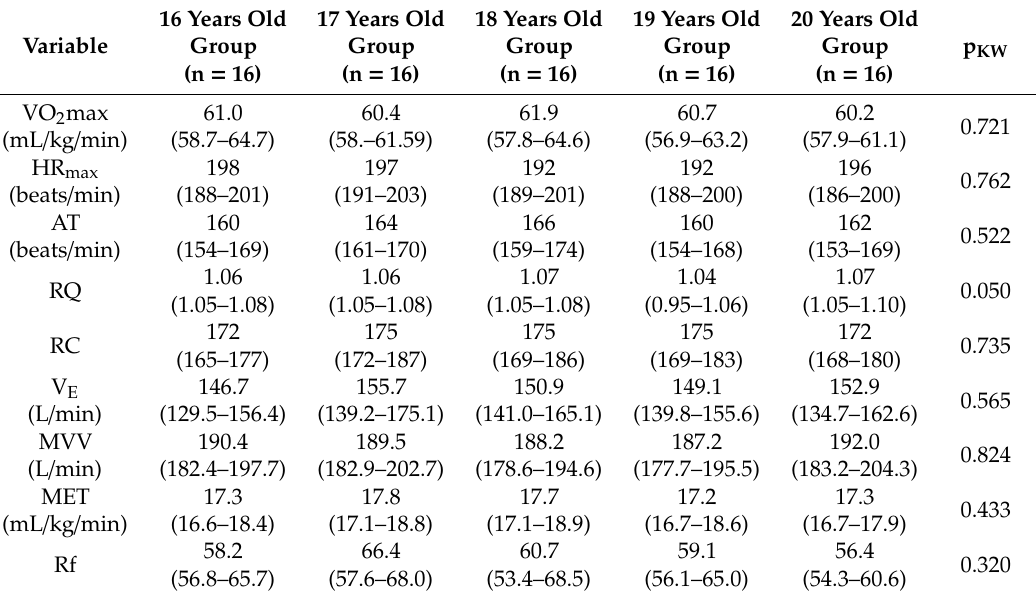
Table 3. Cardiorespiratory fitness measures of participants during the progressive test until